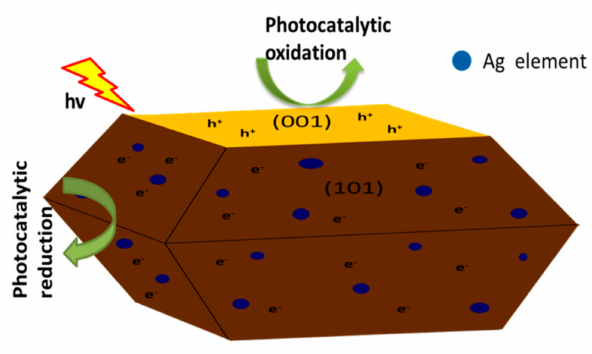
Figure 8. Photocatalytic mechanism diagram of Ag-TiO